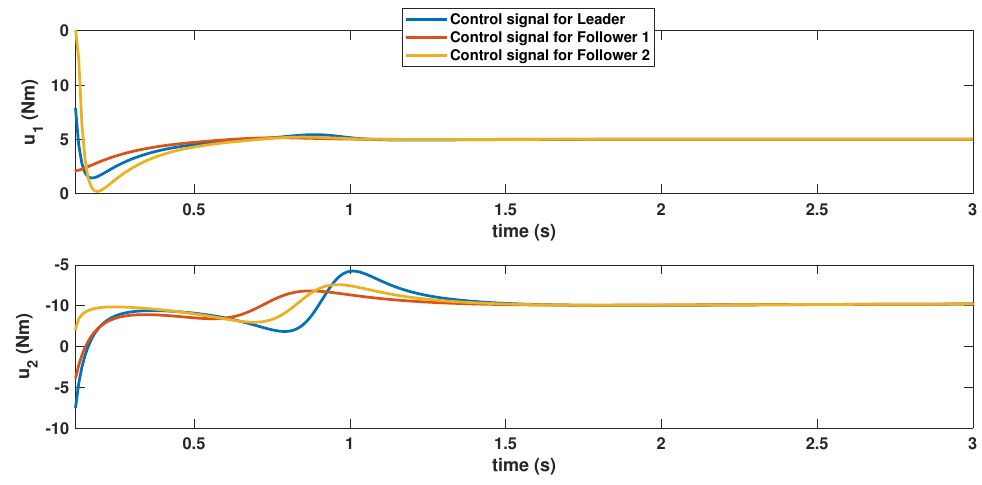
Figure 8. Path 1: Control signals.